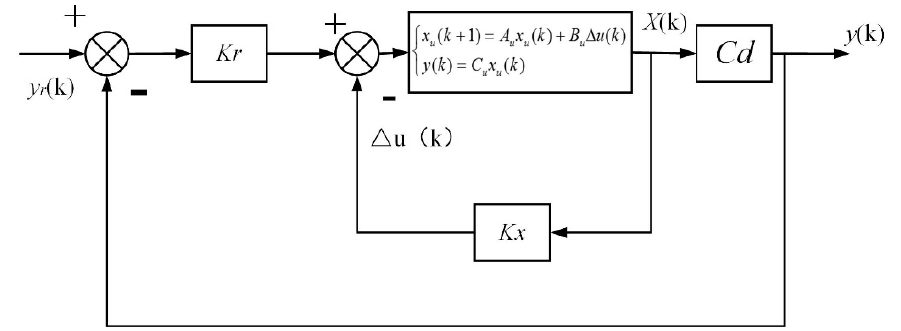
Figure 7. System control block diagram of state extension MPC.